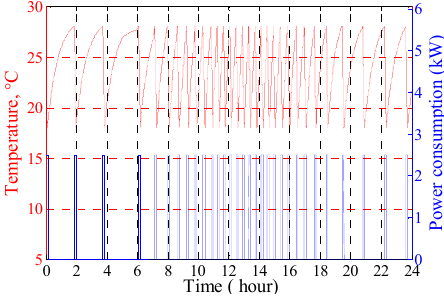
Figure 17. Simulation model of AC power consumption pattern with room temperature.